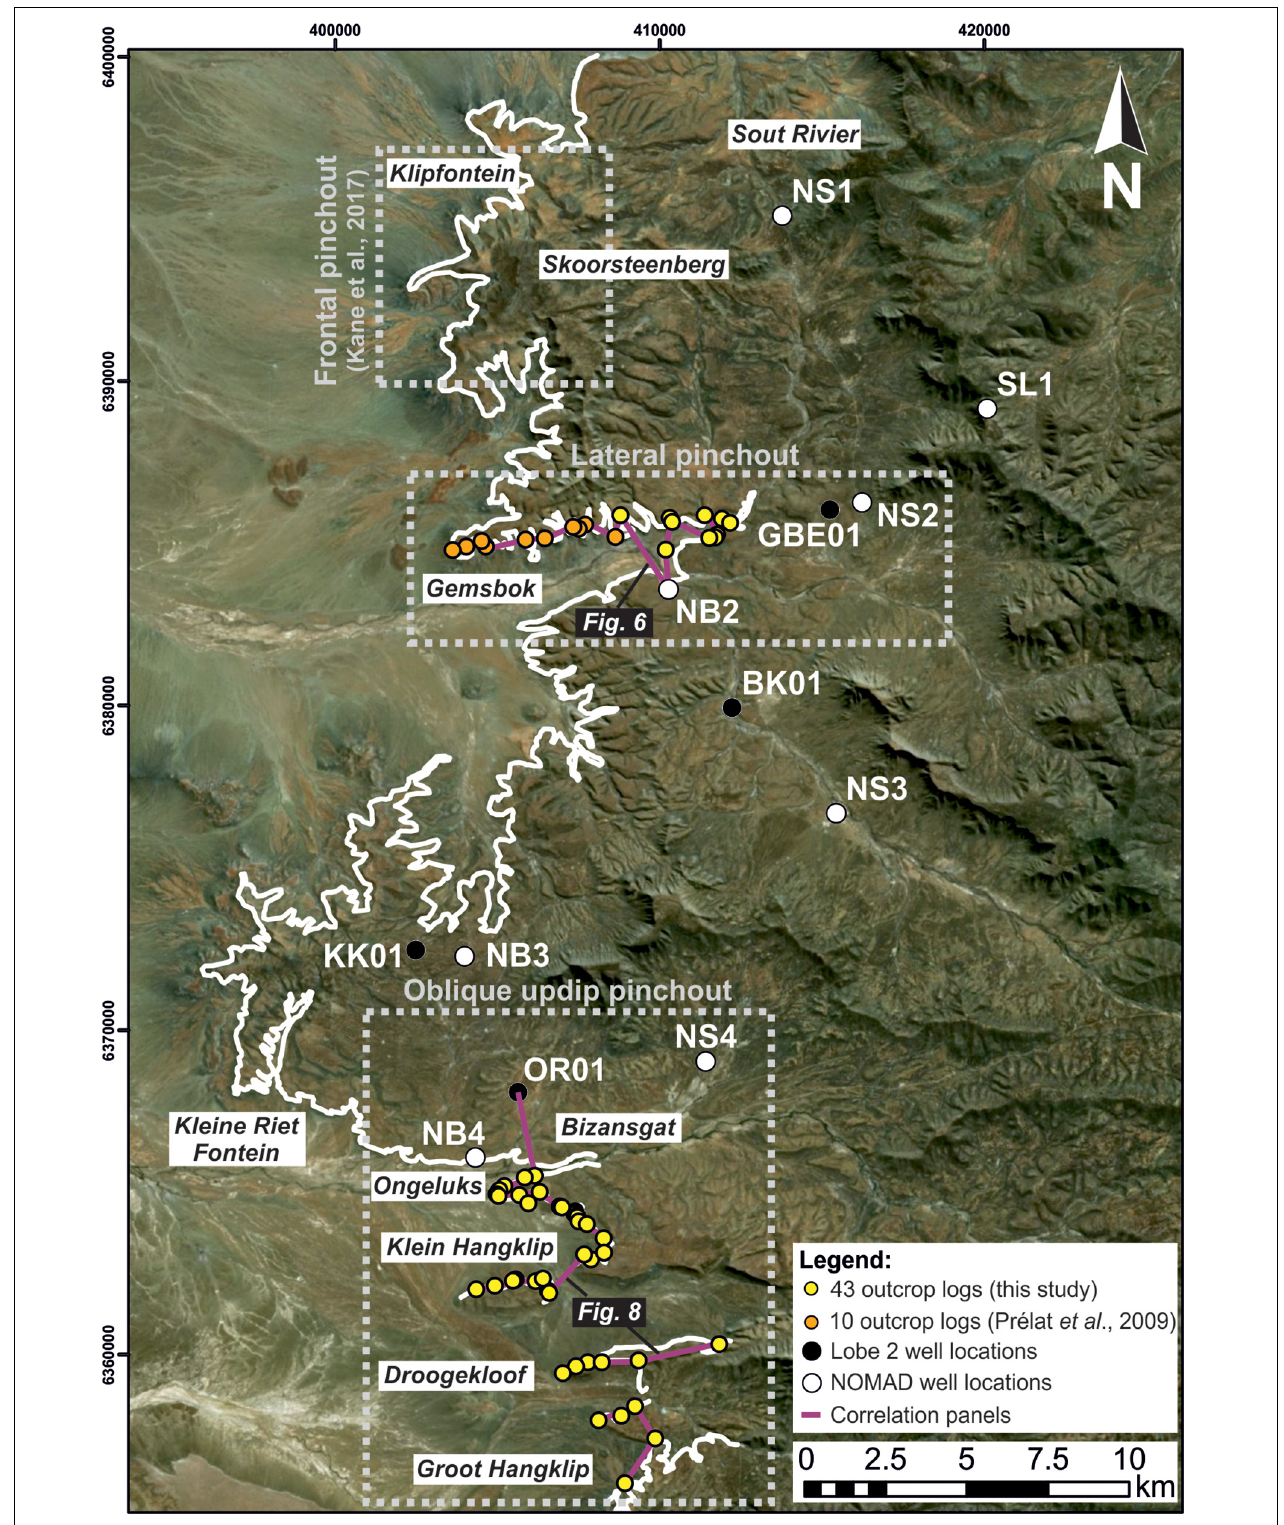
FIGURE 2 | Locations of outcrop logs and cored wells. Fans 3 and 4 outcrops are marked by the white line. The areas studied for the lateral and oblique up-dip pinchouts of Fans 3 and 4 are highlighted. The area covering the frontal pinchout of Fans 3 and 4 studied by Kane et al. (2017) is also highlighted. Image taken from ArcMap: Esri, DigitalGlobe, GeoEye, Earthstar Geographics, CNES/Airbus DS, USDA, USGS, AeroGRID, IGN, and the GIS User Community.